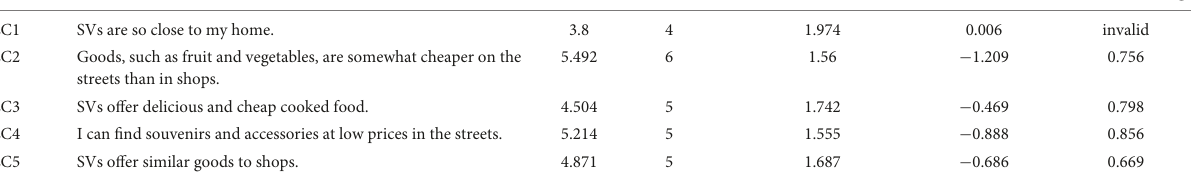
TABLE 7 Measurement properties of low-income consumption. Codes